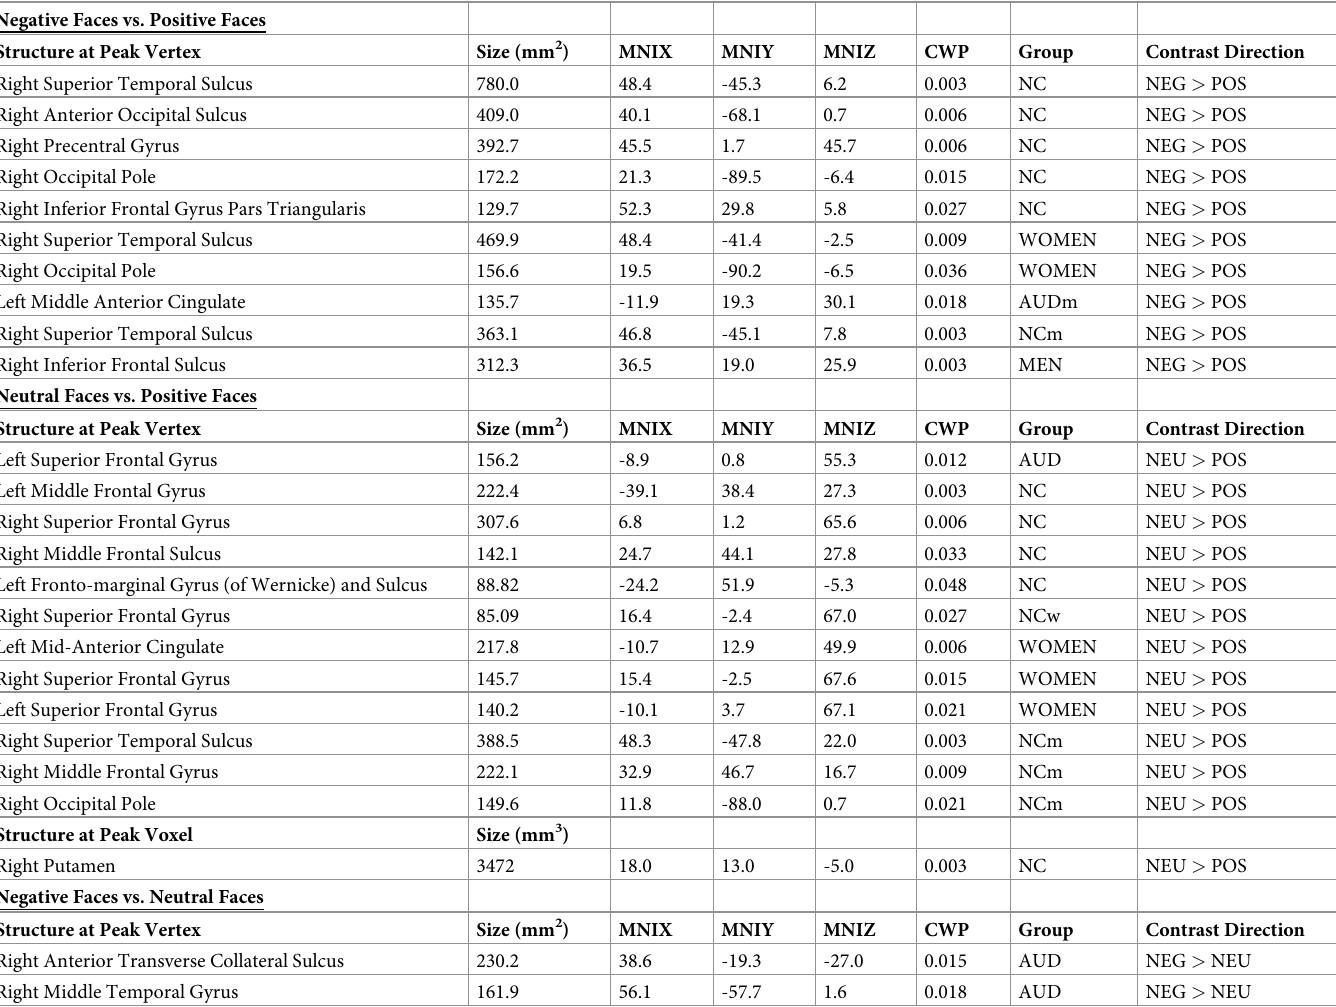
Table 2. Emotion whole brain group cluster analysis: Positive vs. negative, positive vs. neutral, negative vs. neutral. Negative Faces vs. Positive